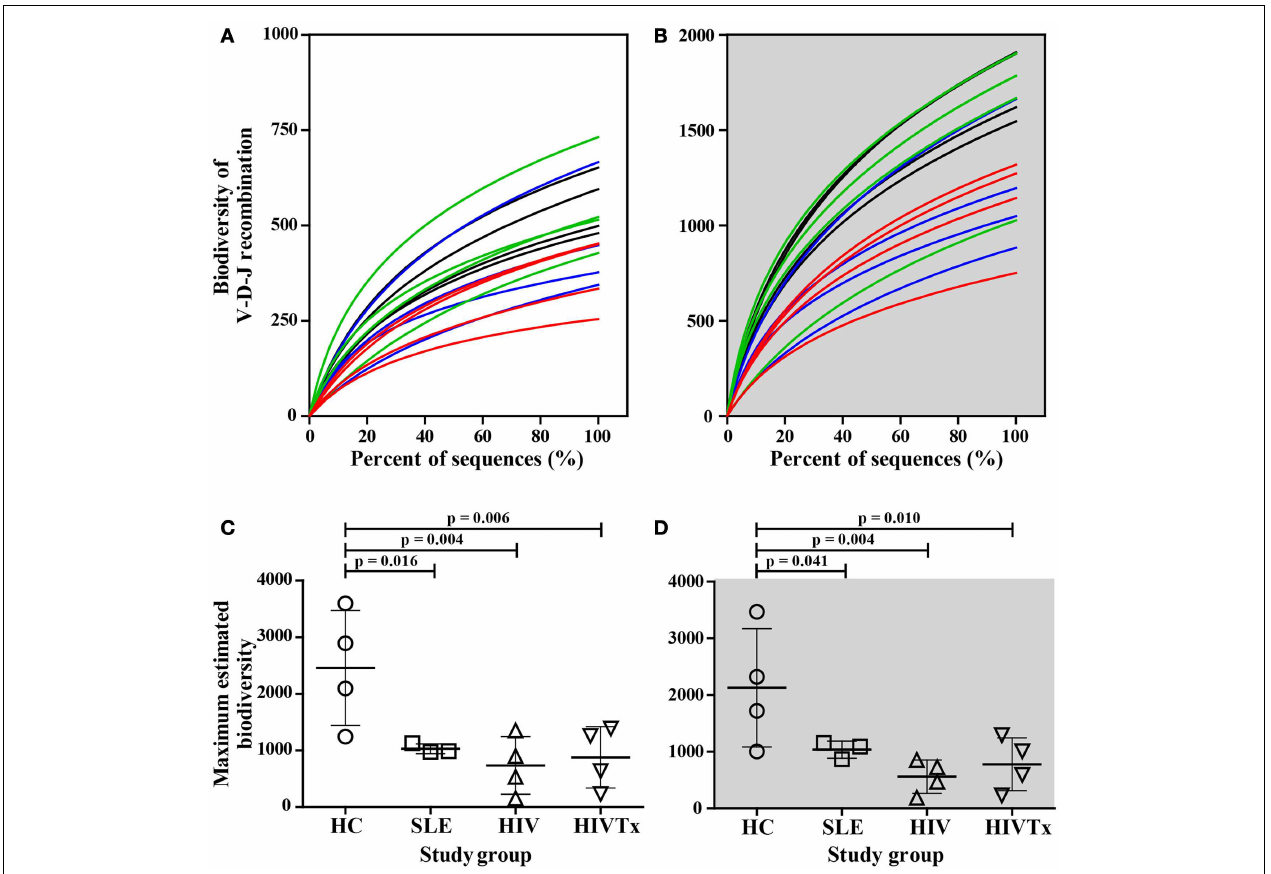
(A) or with SHM (B) . Control of viral replication by ART failed to restore biodiversity in either cell type [green lines in (A,B) ].The maximum biodiversity ofV-D-J allele recombination estimated by Chao1 was significantly greater in HC subjects than in individuals with SLE and HIV infection in input IgM B cells without (C) or with SHM (D) (SLE, p = 0.016 or 0.041; HIV, p = 0.004 for SHM + or SHM + ; HIVTx, p = 0.006 or 0.01,